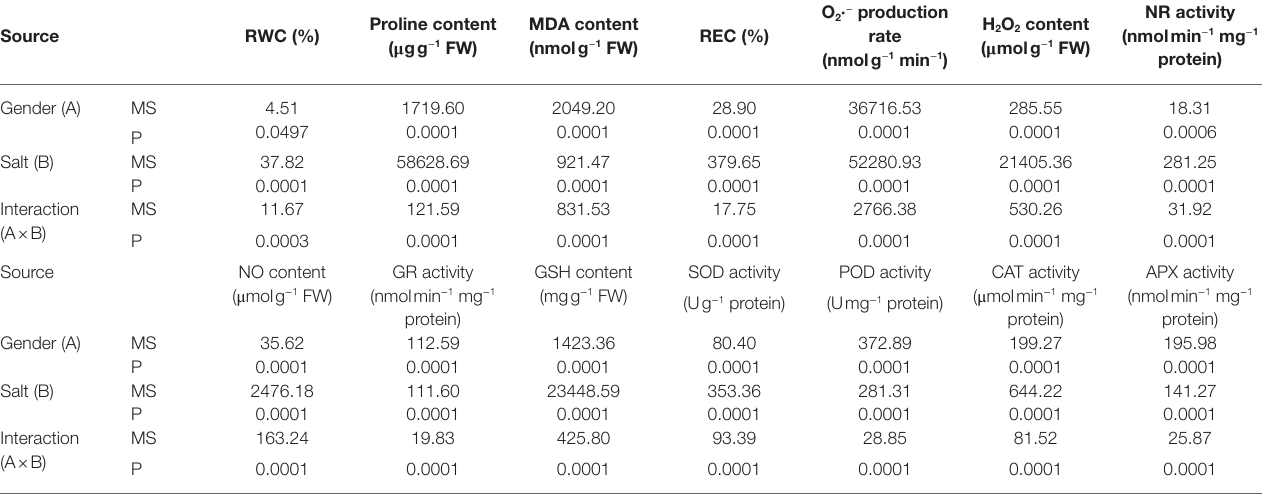
TABLE 2 | Summary of significance levels (two-way ANOVA) for the effects of gender, salt, and their interaction on RWC, proline content, the level of lipid peroxidation, NO content and NR activity, GSH content and GR activity, and antioxidant enzyme activities.